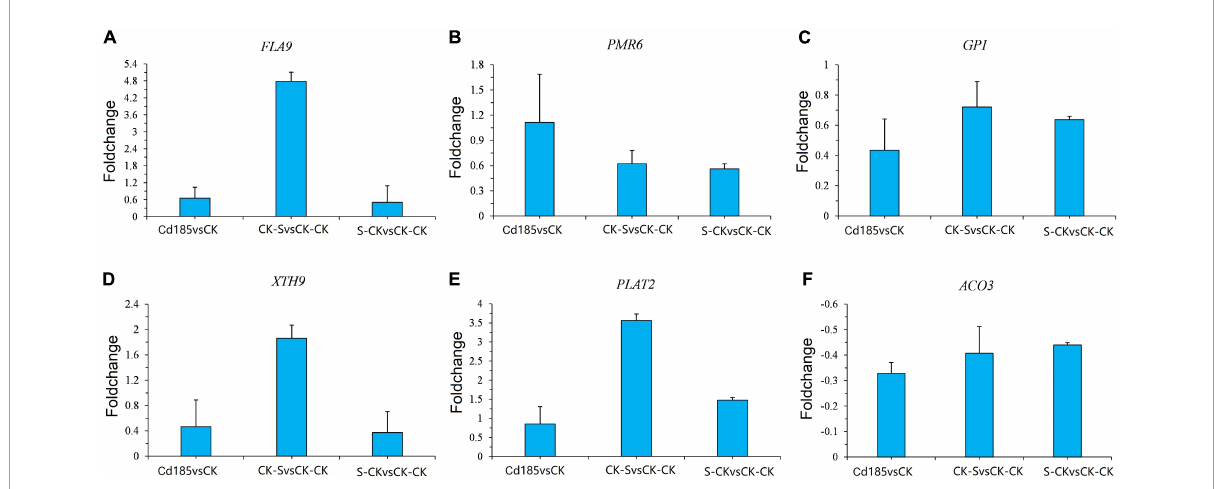
FIGURE8 Validation of expression pattern of TMGs by qRT-PCR. (A–F) qRT-PCR results for six randomly selected TMGs. The y -axis represents the log 2 ratios between comparison pairs along the x -axis. Relative expression quantification was carried out using the 2 - (cid:49)(cid:49) Ct method, with UBQ10 as the internal reference gene. Error bars represent mean ± SE ( n =